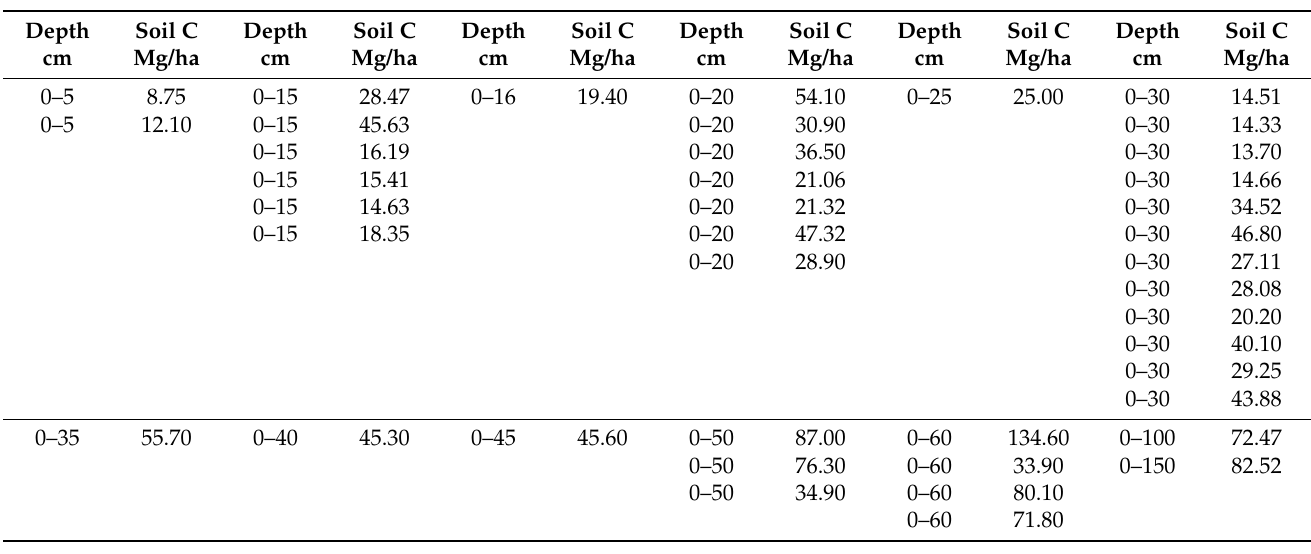
Table 2. Soil organic carbon stocks for old-growth and disturbed miombo woodlands [18,19,22,24,30–41]. Note: Data in the same columns are from one or more of the given sources.